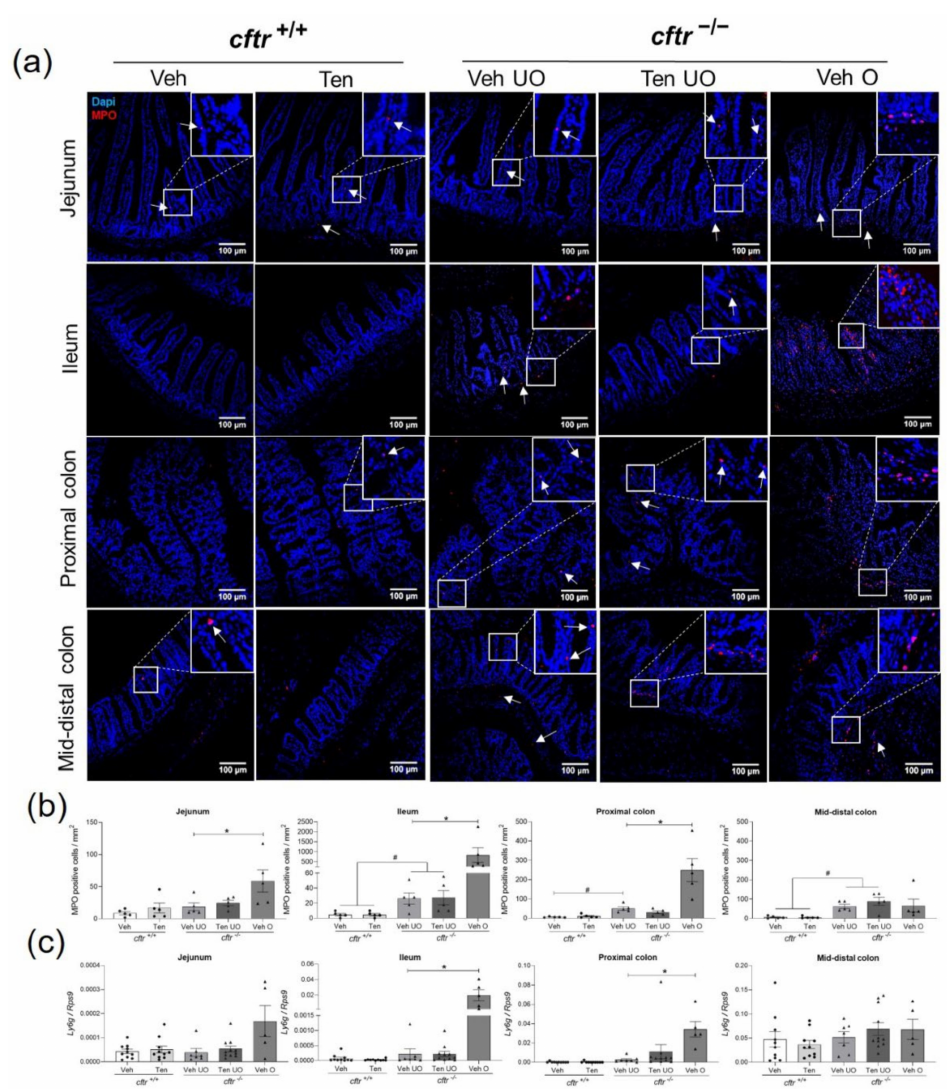
Figure 7. Leucocyte infiltration in obstructed cftr − / − mice treated with vehicle. ( a ) Representa- tive images of MPO-stained cells (indicated by white arrows) in the jejunum, ileum, proximal colon, and mid-distal colon in cftr +/+ and cftr − / − mice treated with either the vehicle or tenapanor (n = 5/genotype/group/intestinal segment). ( b ) Counting of MPO-positive cells showed obvious leucocyte infiltration in the ileum and proximal colon of obstructed cftr − / − mice treated with vehicle. ( c ) Ly6g mRNA expression further confirmed this observation. Each dot/triangle represents one mouse. Veh—vehicle, Ten—tenapanor, UO—unobstructed, O—obstructed. Data are represented as means ± SEM. # is used to represent the statistical analysis performed between the two different genotypes and * is used to represent the statistical analysis performed between the vehicle and tenapanor groups or between unobstructed and obstructed vehicle groups. # and *, p <